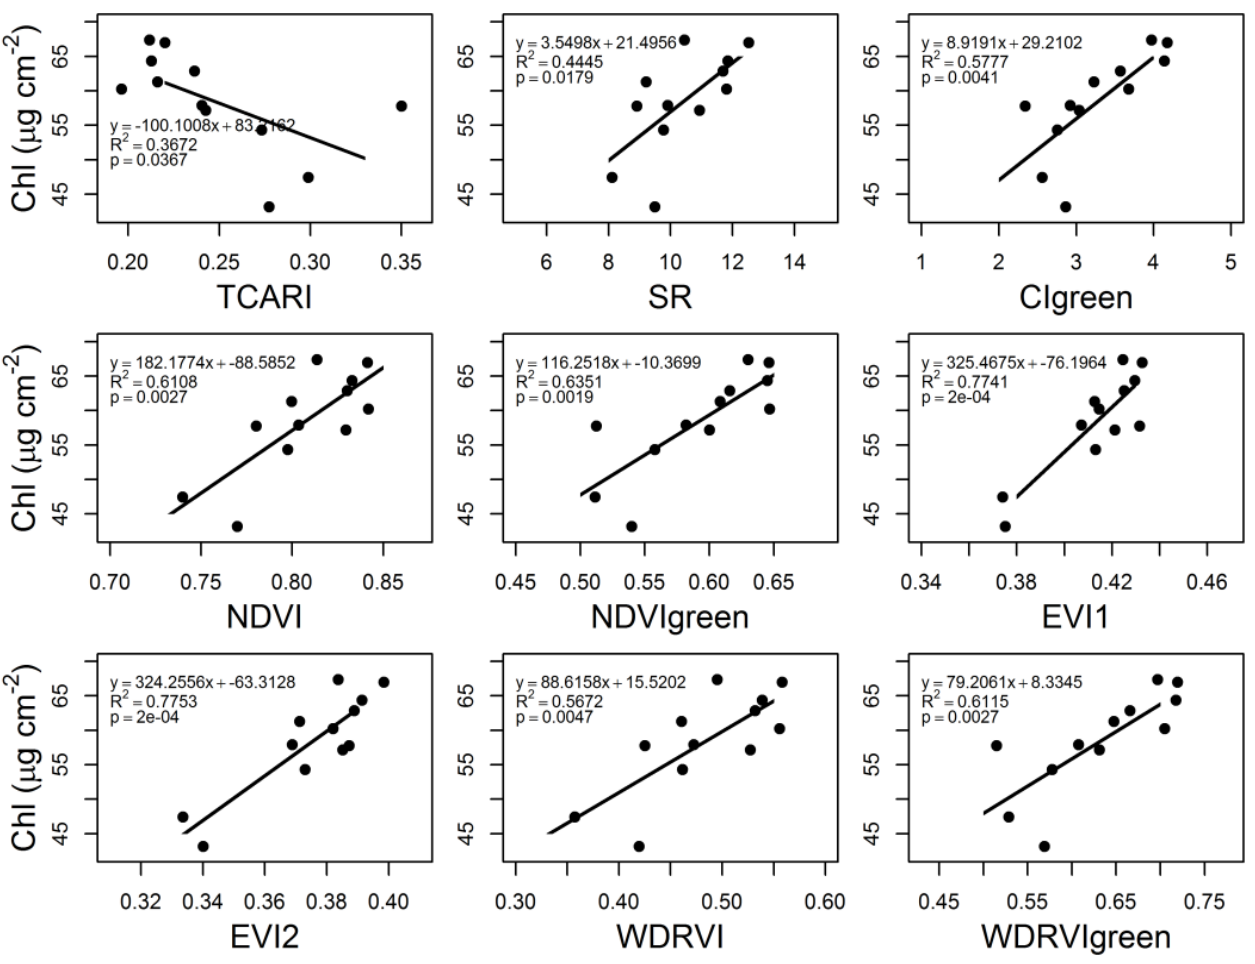
Figure 6. Correlations between VIs and CC ( μ g·cm − 2 ) at ESU